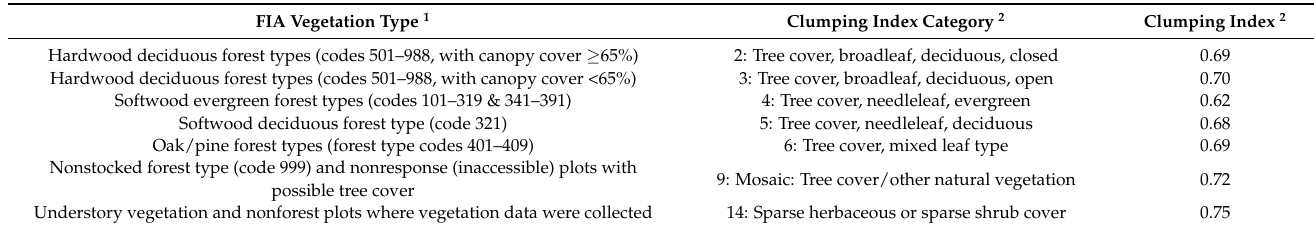
Table 2. Look-up table used to assign clumping index values to each vegetation type for method LAI4. Clumping index categories that do not occur in the study area are